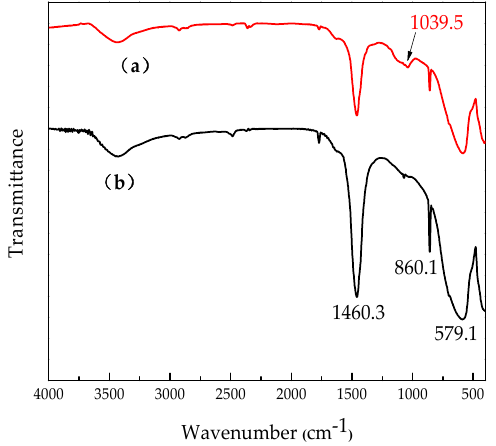
Figure 4. FT-IR spectra of ( a ) 40 wt % nanocomposite, and ( b ) the cured epoxy resin.